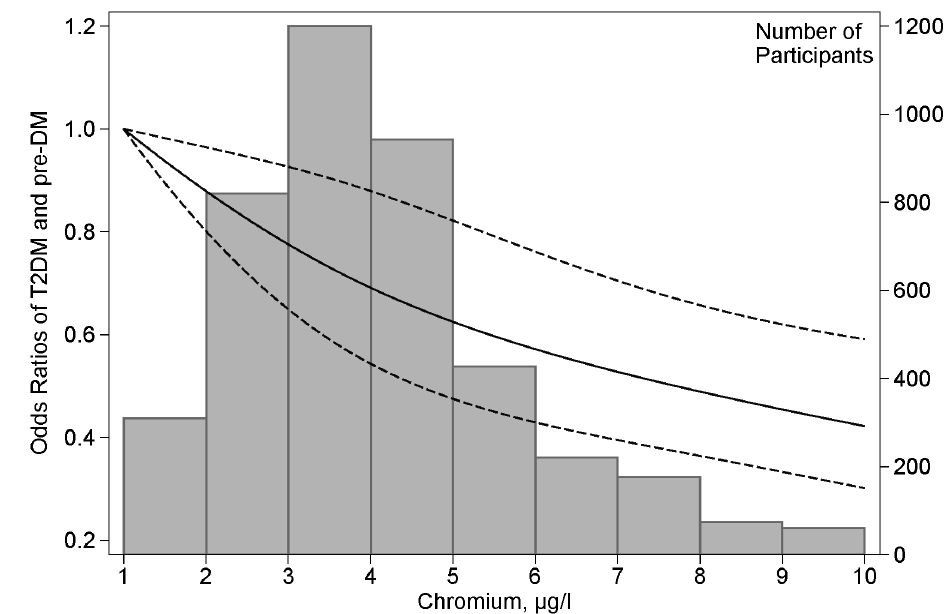
Figure 1. Odds ratios of T2DM and pre ‐ DM by plasma chromium concentrations. Lines represent odds ratios (95% CIs) based on restricted cubic splines for plasma chromium concentrations with knots at the fifth, 50th, and 95th percentiles. Odds ratios were estimated using a logistic regression model after adjustments for age, sex, BMI, current smoking status, current alcohol drinking status, family history of diabetes and hypertension. Bars represent the numbers of participants; nine equally sized bins were selected from the second to the 98th percentiles of chromium distribution. The chromium ‐ diabetes association was not significantly different by sex, BMI, smoking, or history of hypertension (Table 3). Significant interactions were observed between chromium and age, and chromium and alcohol drinking.